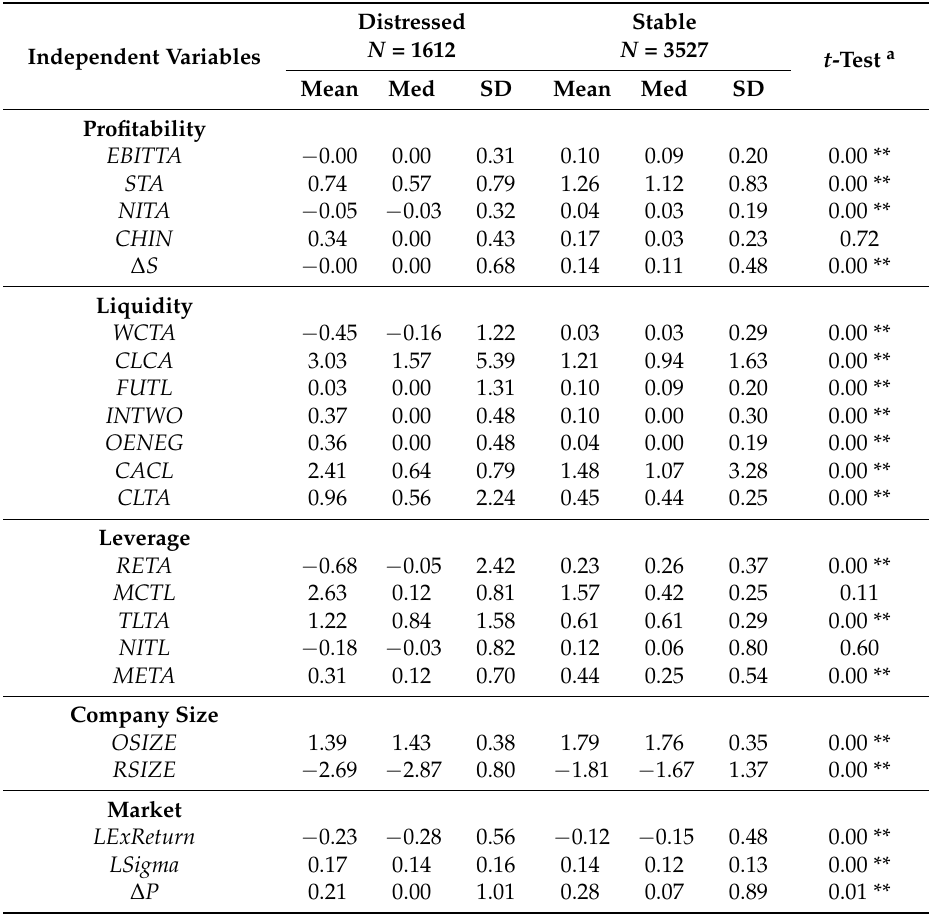
Table 4. Descriptive statistics of distressed and stable firms.